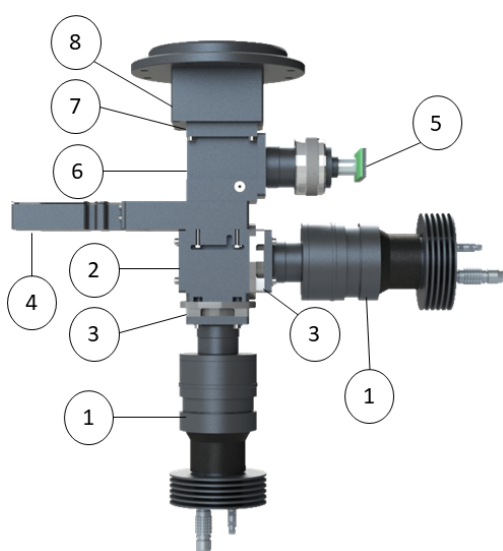
Figure 4. The detection unit after telescope A, containing the opti- cal elements that are used for the detection of the polarization state of the backscattered light, with the signals recorded at the two APDs (1). It also contains a PBS (2), followed by cleaning polarizing sheet filters (3), a shutter for dark measurements (4), a camera for the alignment (5), a turning mirror for redirecting the light to the camera (6), an interference filter for the reduction of the background light (7), and a mechanical rotator (8) for accurately rotating a HWP for the system calibration (Sect. 4). The detection unit after telescope B is the same, with a QWP placed before the PBS.